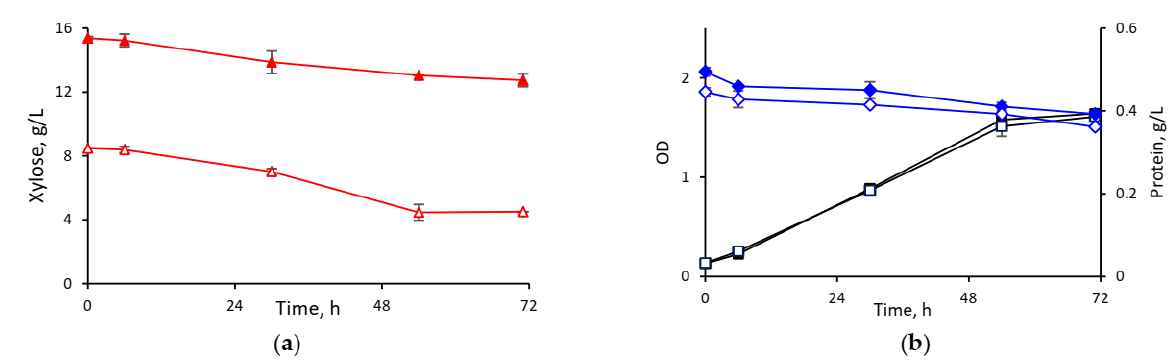
Figure 3. Sugar consumption ( a ) and cell growth and protein consumption ( b ) during cultivation of B. atrophaeus BU4 in synthetic media containing 16 g/L (filled symbols) or 8 g/L (empty symbols) initial xylose. Xylose, triangles; OD, squares; protein, rhombs.